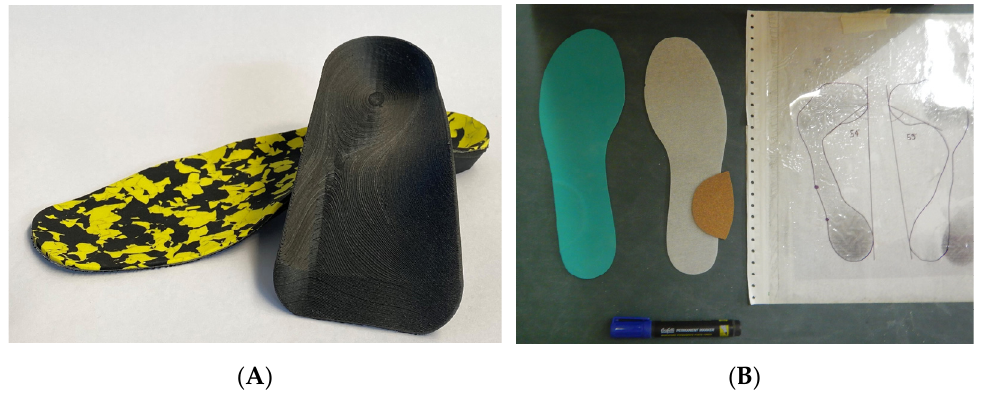
Figure 2. All the participants had negative plaster casts taken in subtalar joint neutral position with the participant in supine position. Biomechanical CFO ( A ) were made of a 2 mm thick carbon shell with a straight extrinsic ethylene-vinyl-acetate (EVA) rearfoot post. Postural CFO ( B ) were made with a half-moon anti-varus elements (cork) having a 1.5 mm thickness.